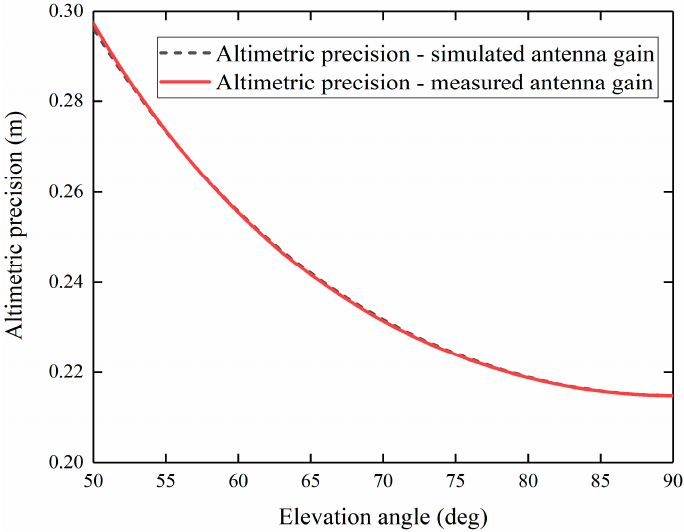
Figure 10. Altimetric precision of the NDCPPA verification prototype: the comparison of simulated antenna gain and measured antenna gain brought into the simulation environment.